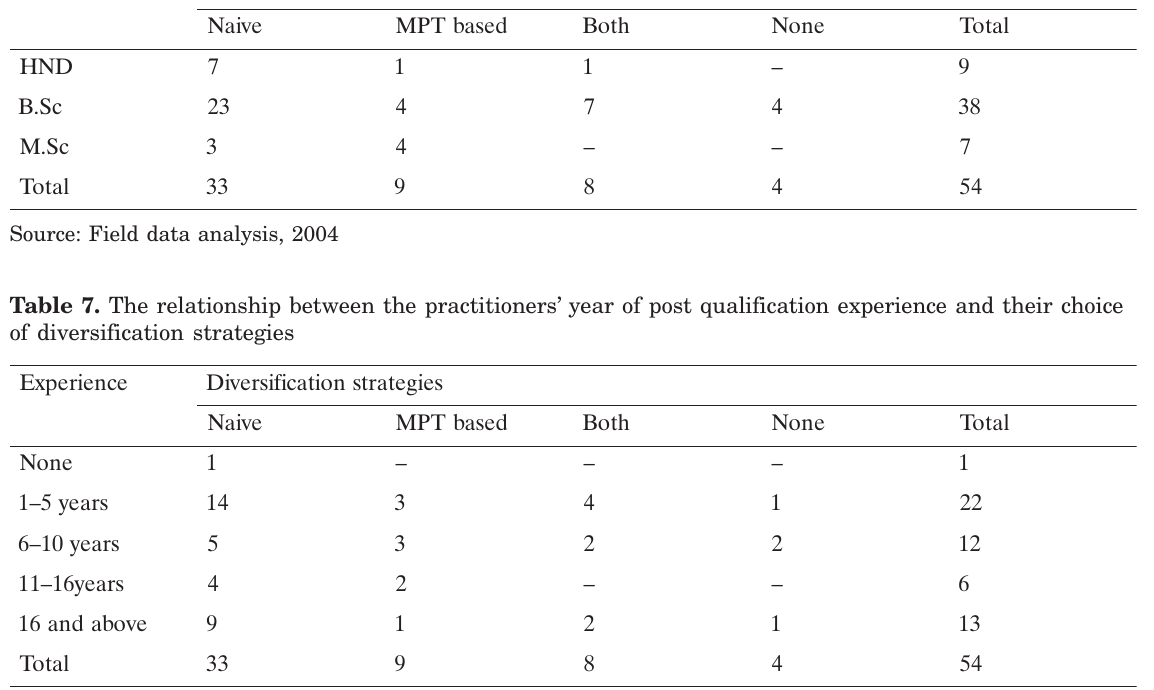
Table 6. The relationship between the practitioners’ educational qualifications and their choice of diversification strategies snoitacifilauQ